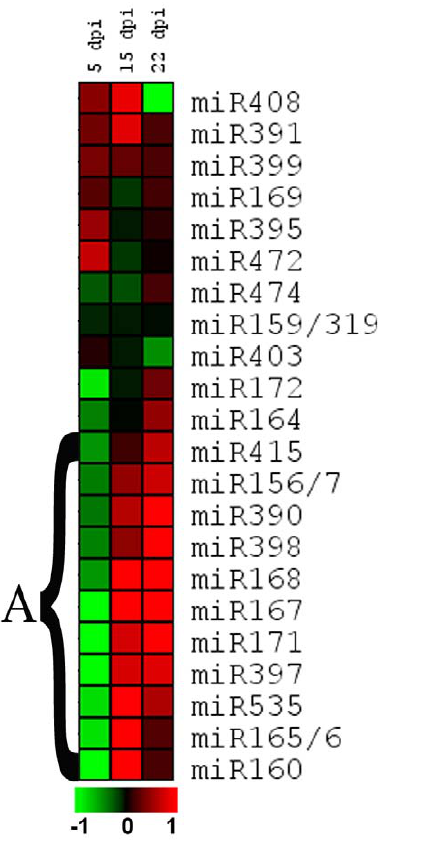
Figure 5. Temporal profiling of miRNAs accumulation follow- ing TMV infection. Systemic, non-inoculated tobacco leaves were sampled from virus- and mock-inoculated plants (n=6 for each day and treatment) at 5, 15 and 22 dpi. miRNAs accumulation in TMV-inoculated plants were compared to those corresponding to mock-inoculated plants and the relative accumulation was calculated as the ratio between virus- and mock-inoculated samples at each time point. These ratios were log2 transformed and further analyzed with hierarchical clustering with average linkage. False-color scale indicates lower (green) or greater (red) miRNA accumulation in TMV-infected plants respect to mock-inoculated ones. The horizontal bar shows the log2-based scale. See Materials and Methods for further